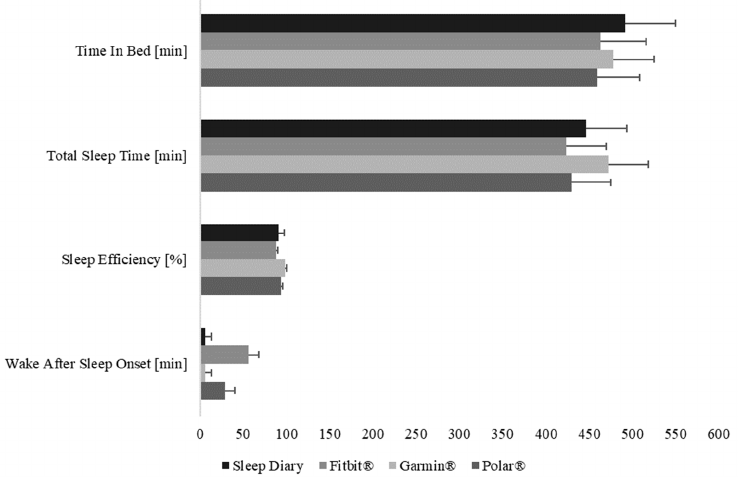
Figure 2. Overview of the analyzed sleep variables presenting time parameters in minutes and sleep efficiency in percentage.